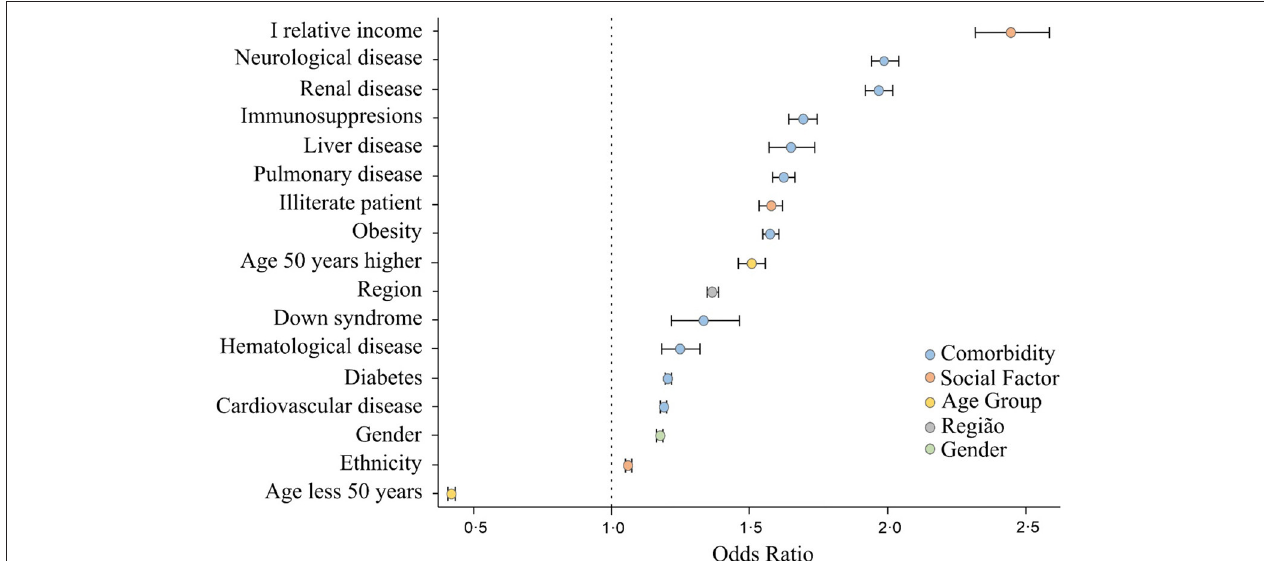
FIGURE 4 | Social and risk factor indicators that lead to mortality for patients hospitalized with COVID-19.